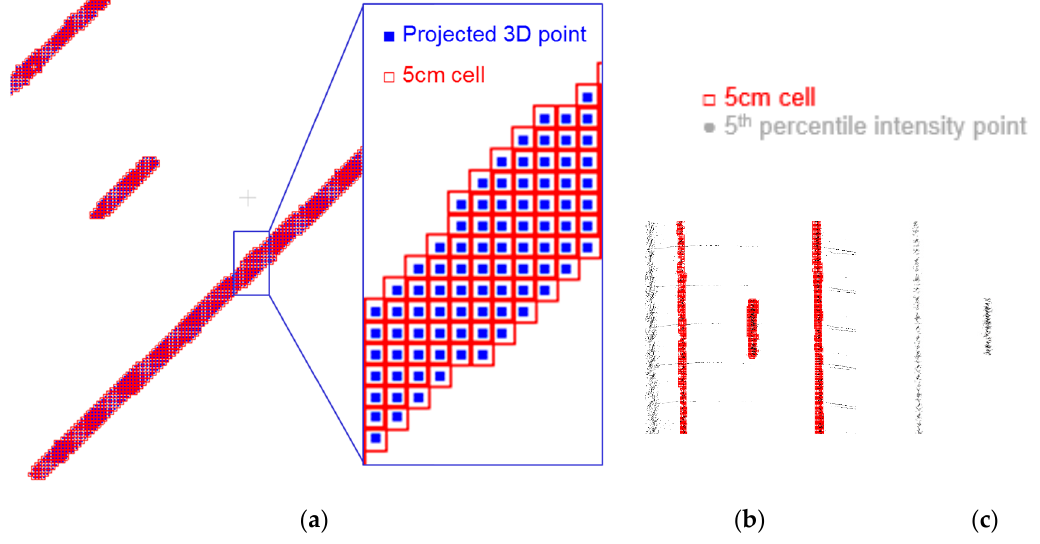
Figure 13. U-net prediction refinement: ( a ) mask regions formed by 5-cm cells, ( b ) two-dimensional (2D) masks overlaid on points whose intensity is in the 5th percentile intensity of the original point cloud, and ( c ) predicted lane markings.